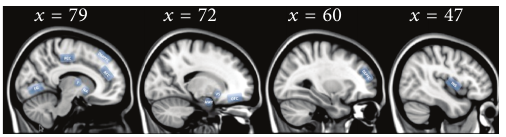
Figure 1: Overview of brain structures playing a role in the neurobiological mechanisms of postpartum depression as dis- closed by BOLD activation fMRI studies [39–44]. Insula (INS), dorsolateral prefrontal cortex (DLPFC), dorsomedial prefrontal cortex (DMPFC), orbitofrontal cortex (OFC), thalamus (T), nucleus accumbens (NA), amygdala (AMY), ventral striatum (VS), fusiform gyrus (FG), anterior cingulate cortex (ACC), and posterior cingulate cortex (PCC). A template structural image provided with FSL software MNI 152 1mm was used for anatomical reference. MNI coordinates of the selected slices are also